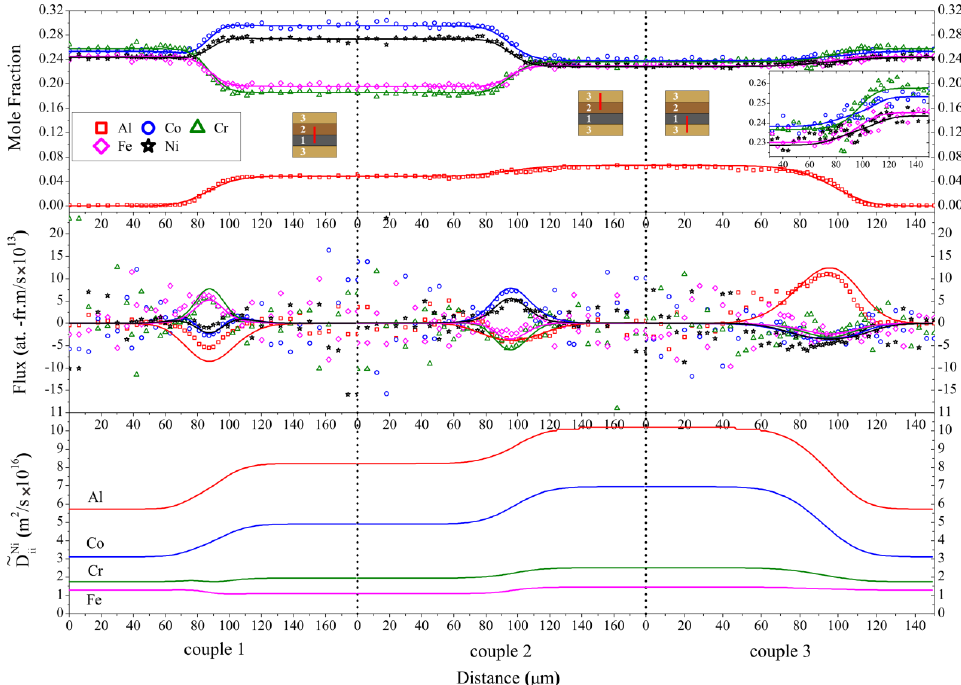
Figure 2. Comparison between the experimental and simulated concentration profiles/interdiffusion fluxes of diffusion couples annealed at 1273 K for 46 h as well as the evaluated diagonal interdiffusivities. Symbols are due to the experimental measurements.